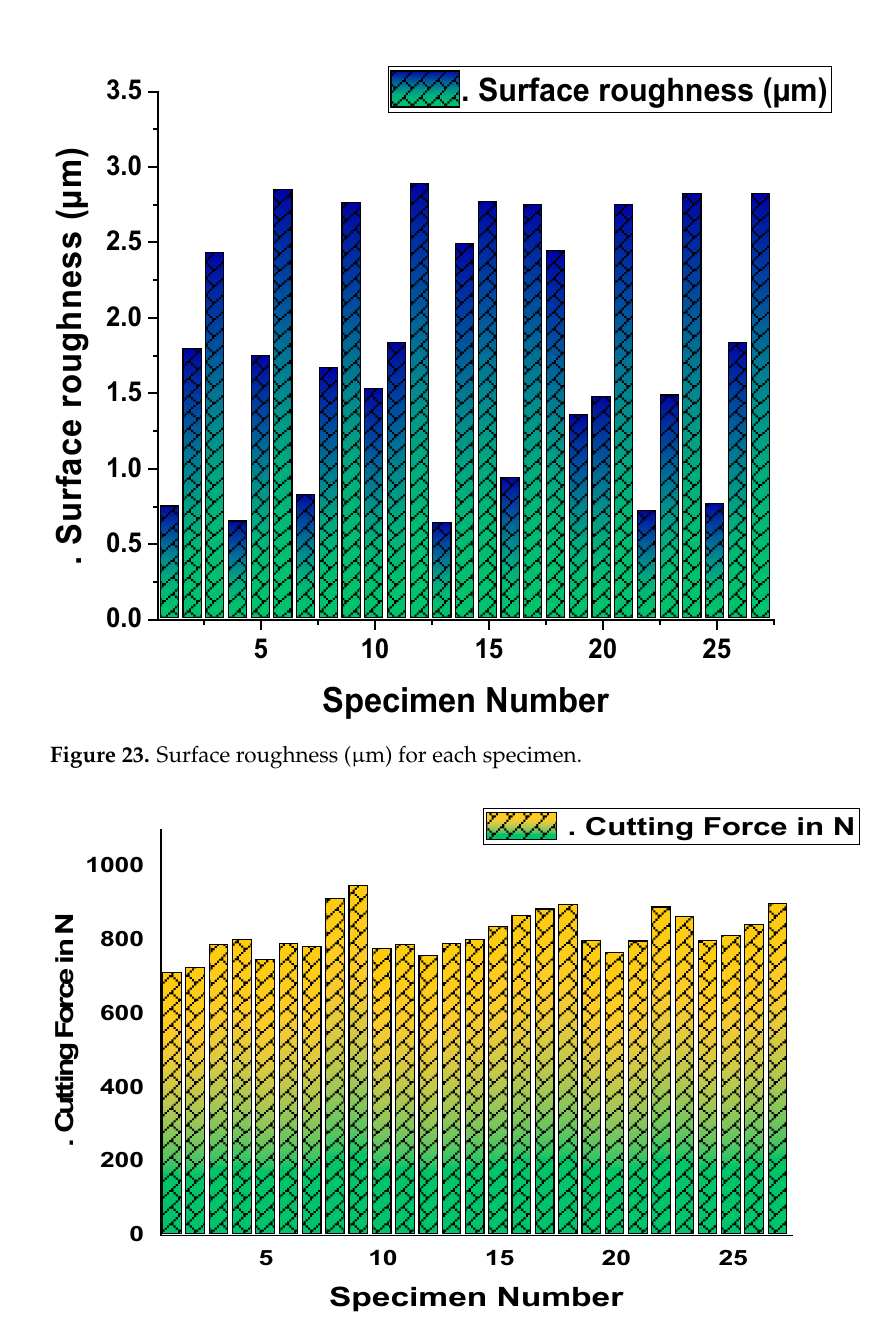
Figure 24. Cutting force (N) for each specimen.